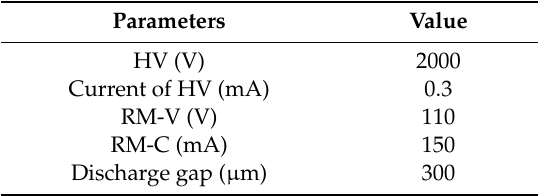
Table 3. HV- µ EAM parameters.